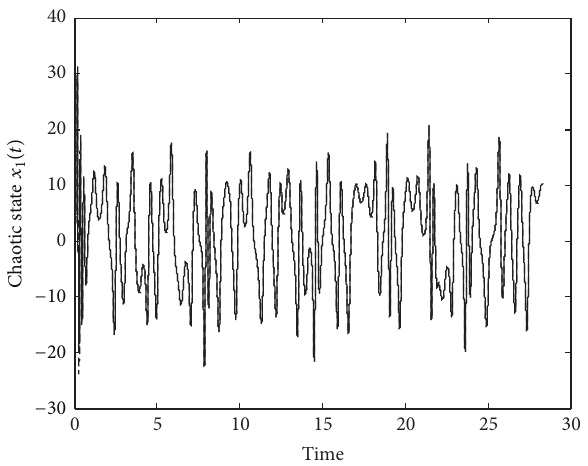
Figure 3: Actual chaotic state 𝑥 1 (dashed line) and its estimate ̂𝑥 1 (solid line).